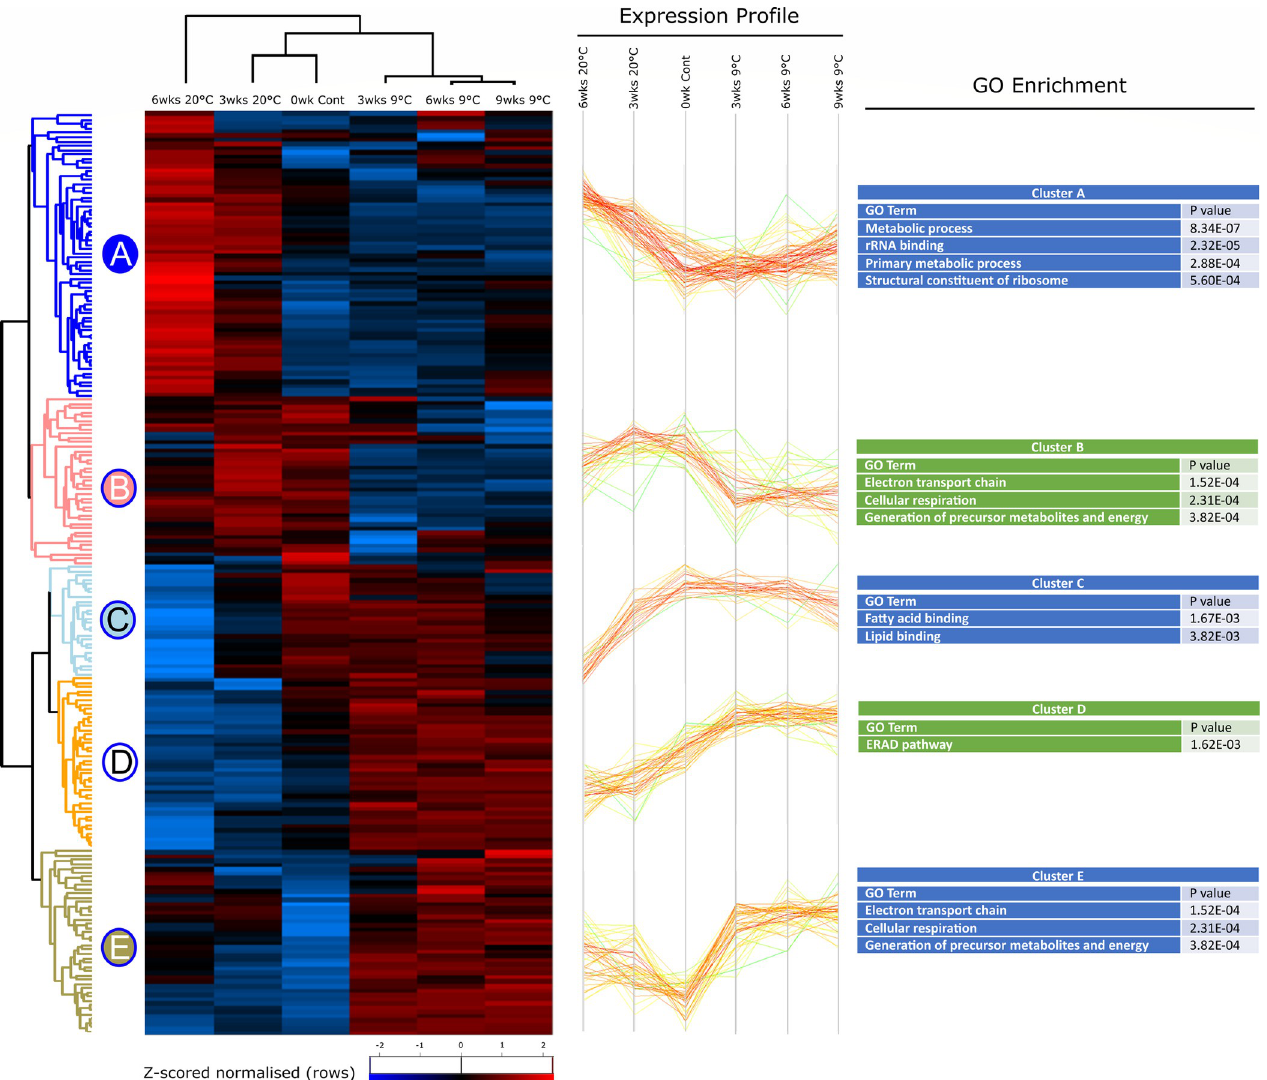
Fig 2. Heat map of S . carpocapsae statistically significant proteins. Two-way unsupervised hierarchical clustering of the median Z-score normalised label- free quantification (LFQ) intensity values of all statistically significant proteins (n = 214) for freshly emerged IJs, IJs stored at 9˚C for 3, 6 and 9 weeks or IJs stored at 20˚C for 3 and 6 weeks. Hierarchical clustering resolved 5 distinct clusters. Differences in protein abundance are indicated by colour changes from low (blue) to high (red) protein abundance representative of changes in Z-score normalised log 2 -fold transformed LFQ intensity values. Selected GO terms enriched in each cluster are displayed (right), along with the P value for that